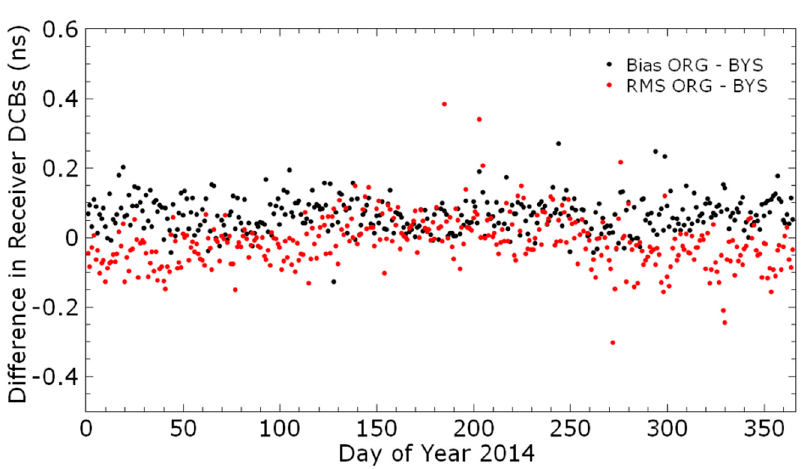
Figure A4. Differences in satellite DCBs between ORG and BYS approaches.